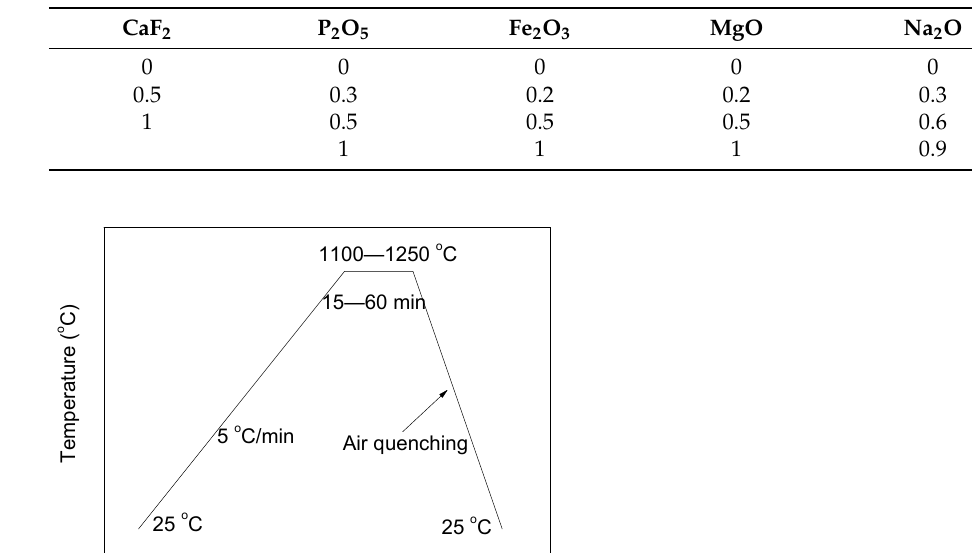
Table 4. Weight percentage of the dopant additions (wt.%).